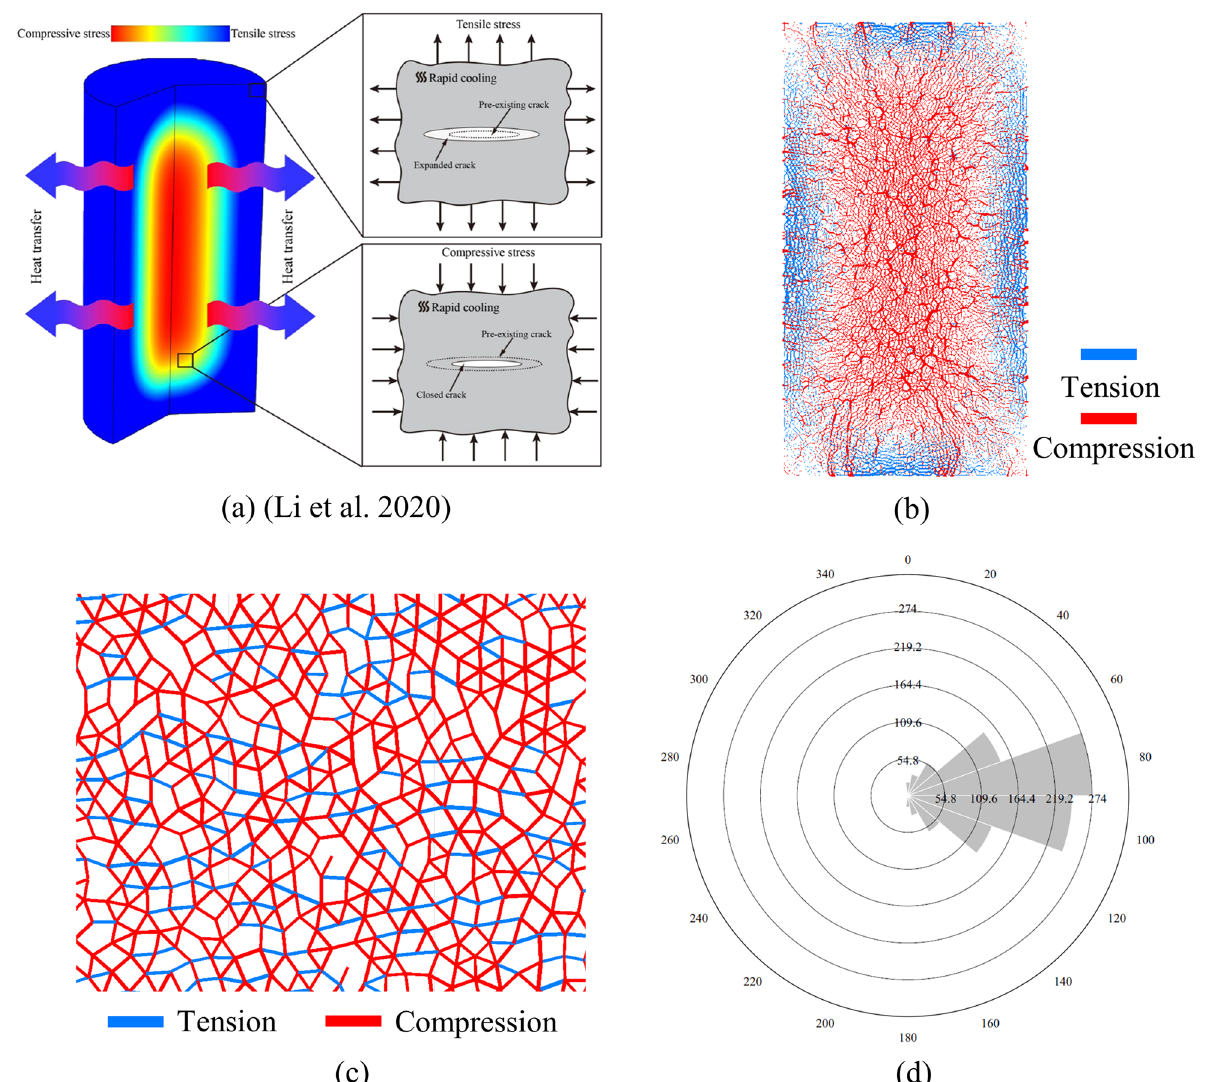
Fig. 16 Stress distribution and crack rose diagram of pre-heated rock in cooling stage a Stress distribution without axial stress studied by Li et al. (2020) b Stress distribution without axial stress studied by